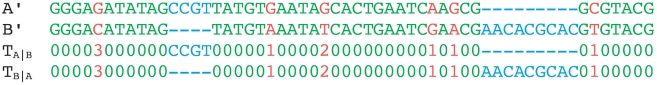
Example of an alignment and of the two translation strings  and .Colors indicate sites with mutations (red), gaps (blue), and conservation (green).